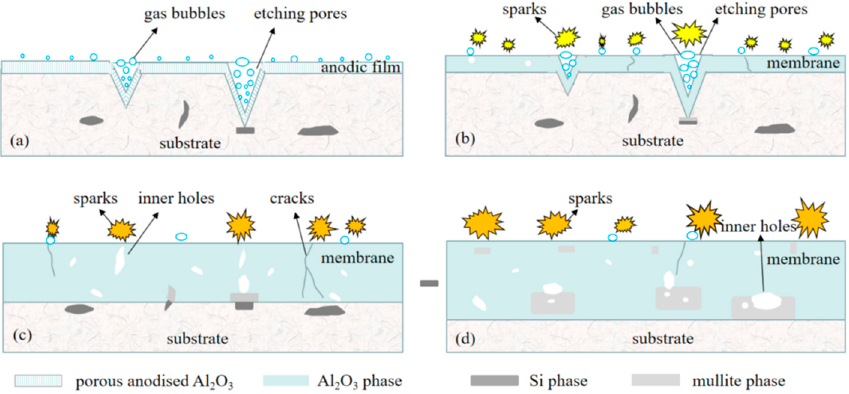
Figure 14. Layer growth model for the Al-Si alloy with etching pretreatment, at the ( a ) Ⅰ , ( b ) Ⅱ , ( c ) Ⅲ, and ( d ) Ⅳ oxidation stages.